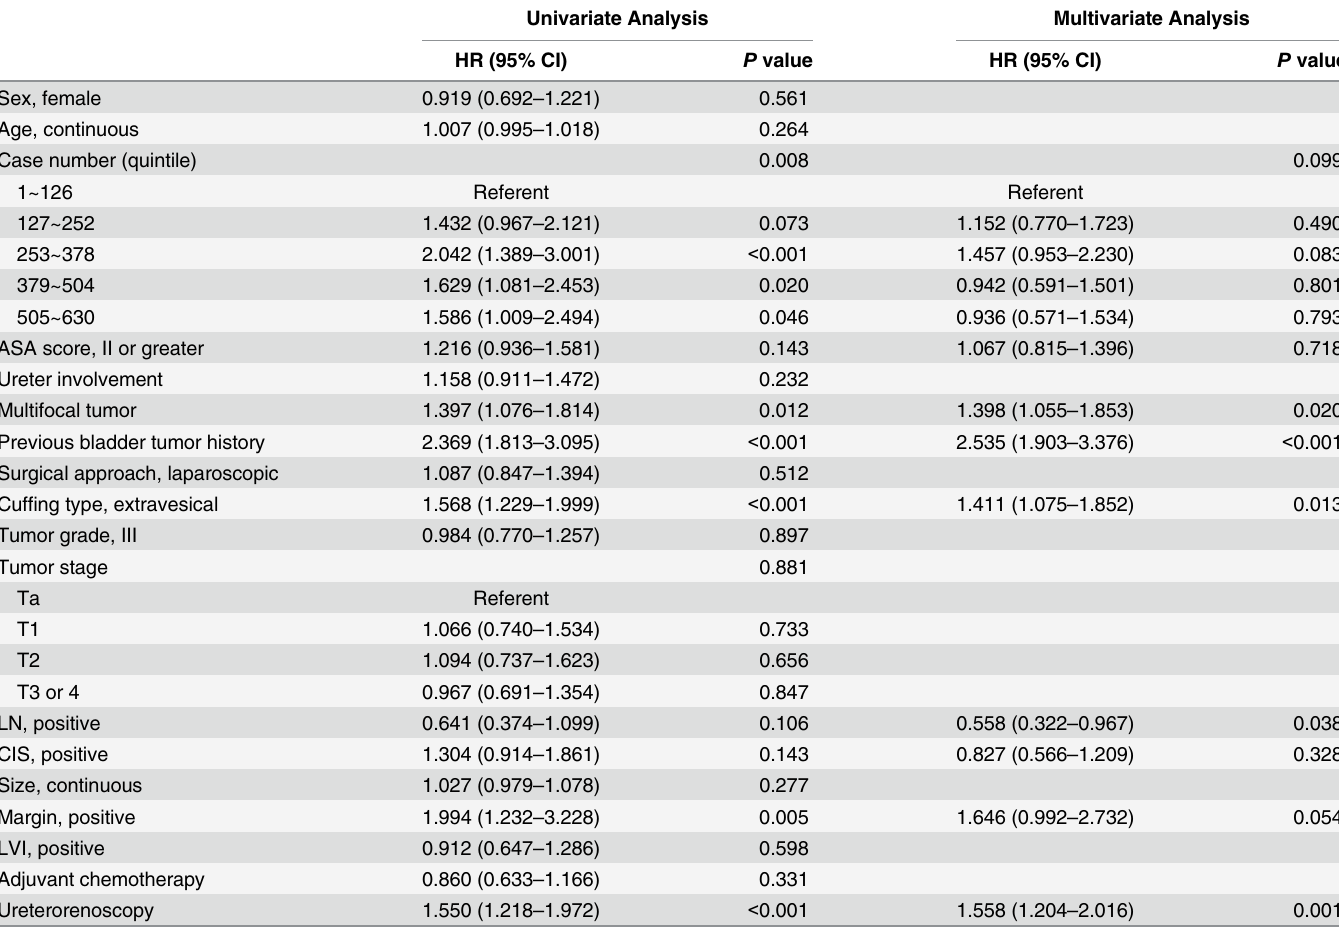
Table 2. Risk factors for predicting intravesical recurrence following radical nephroureterectomy for upper tract urothelial cancer in 630